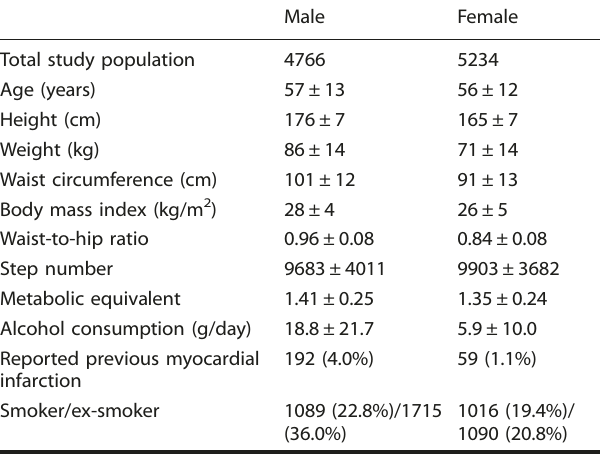
Table 1. Basic characteristics of the LIFE-ADULT study